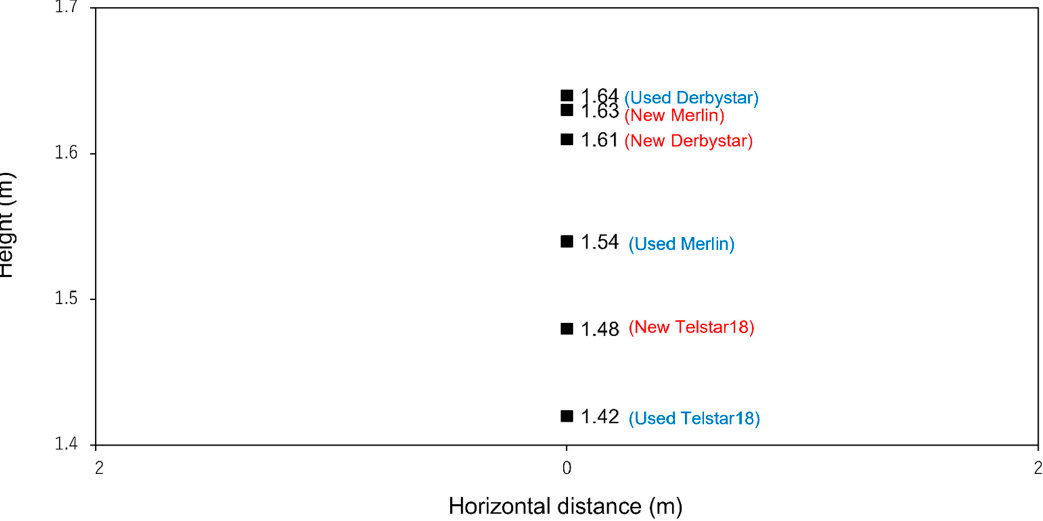
Figure 7. Comparison of the height of the impact point of the soccer ball from the front (initial speed 20 m/s, release angle 15°).